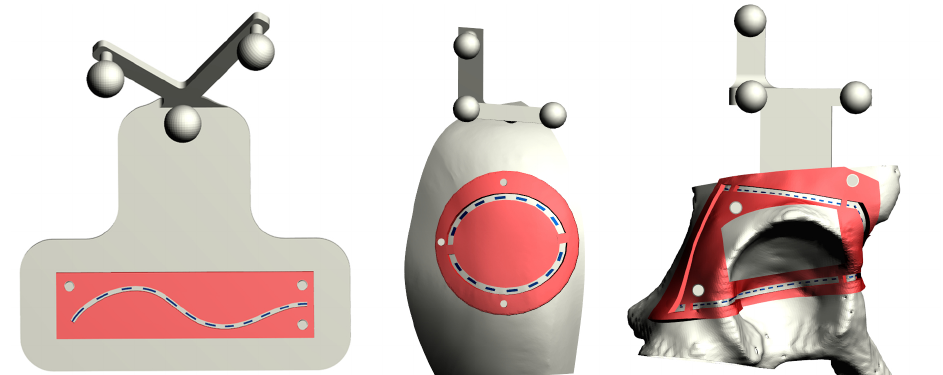
Figure 4. CAD model of the templates designed ad hoc for each phantom to test the accuracy of the trajectories traced by the subjects.